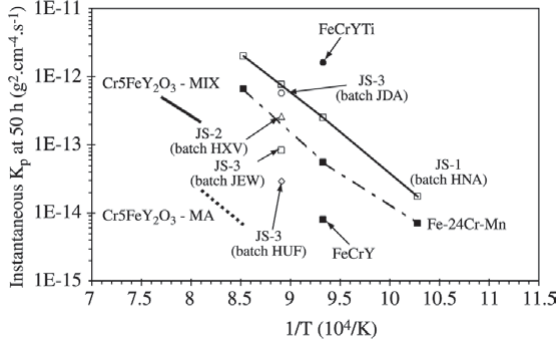
Figure 3. Instantaneous K ture during isothermal oxidation in Ar-20%O ues for the ODS alloy Cr5FeY